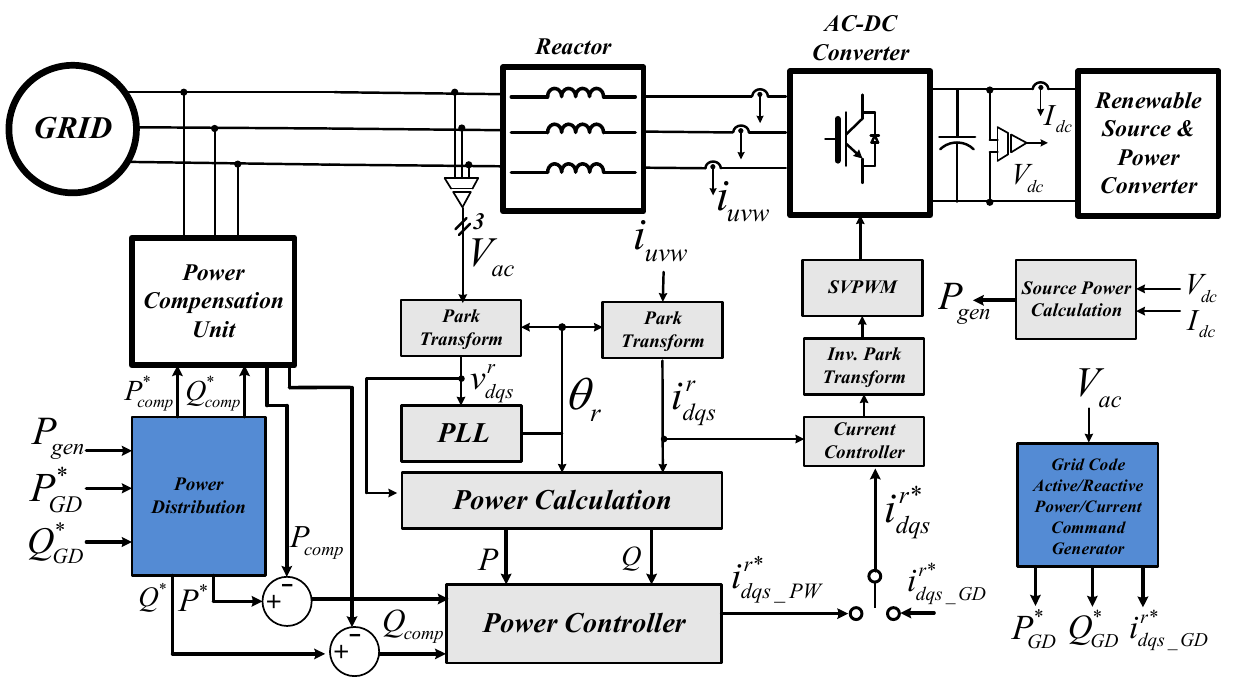
Figure 7. Control block diagram of grid-connected devices in distributed generation.